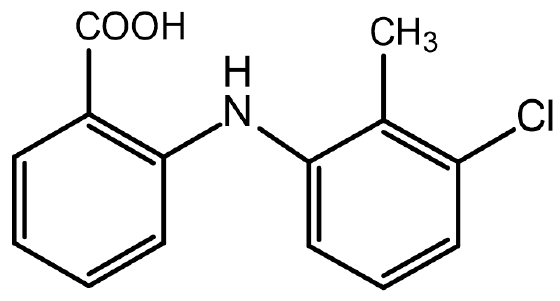
Figure 1. Structure of tolfenamic acid.